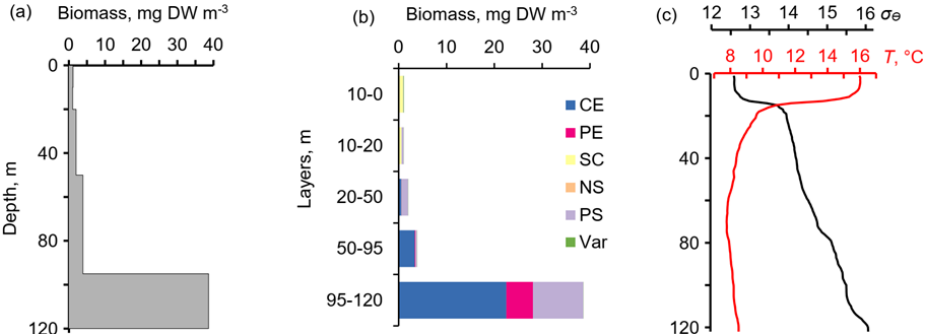
Figure 6. The daytime vertical distributions of (a) total mesozooplankton biomass, (b) zooplankton composition, and (c) temperature ( T ) and density ( σ (cid:50) ) near the mooring site at 12:30–13:20 on 6 October 2013. Temperature and density profiles (c) indicate the selection of sampling strata. CE – Calanus euxinus ; PE – Pseudocalanus elongatus ; SC – small crustaceans; NS – Noctiluca scintillans ; PE – Parasagitta setosa ; Var – varia.